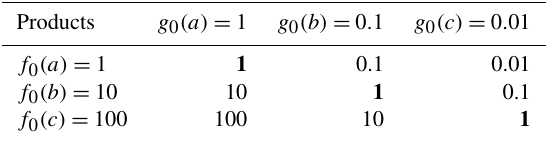
Table A1. Example of encoding for three classes and nine neigh- bors and their associated products. The emboldened main diago- nal shows the situations when the search classes match their corre- sponded values.